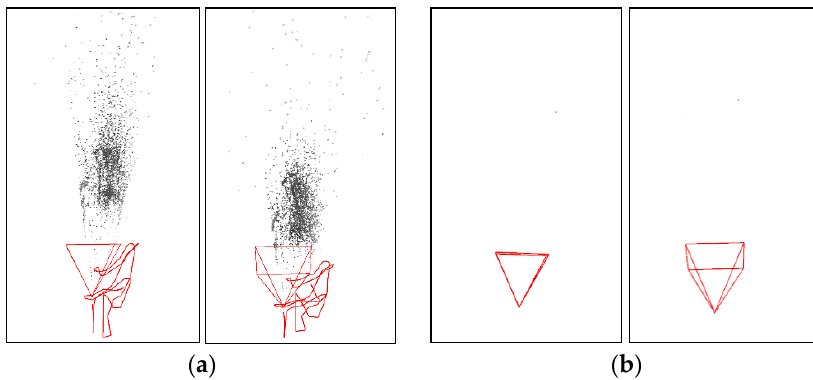
Figure 15. The camera trajectories and point cloud maps estimated by Dynamic-DSO ( a ) and DSO ( b ). The red triangle represents the camera orientation, the red curve is the estimated camera trajectory and the black area is the 3D point cloud map.